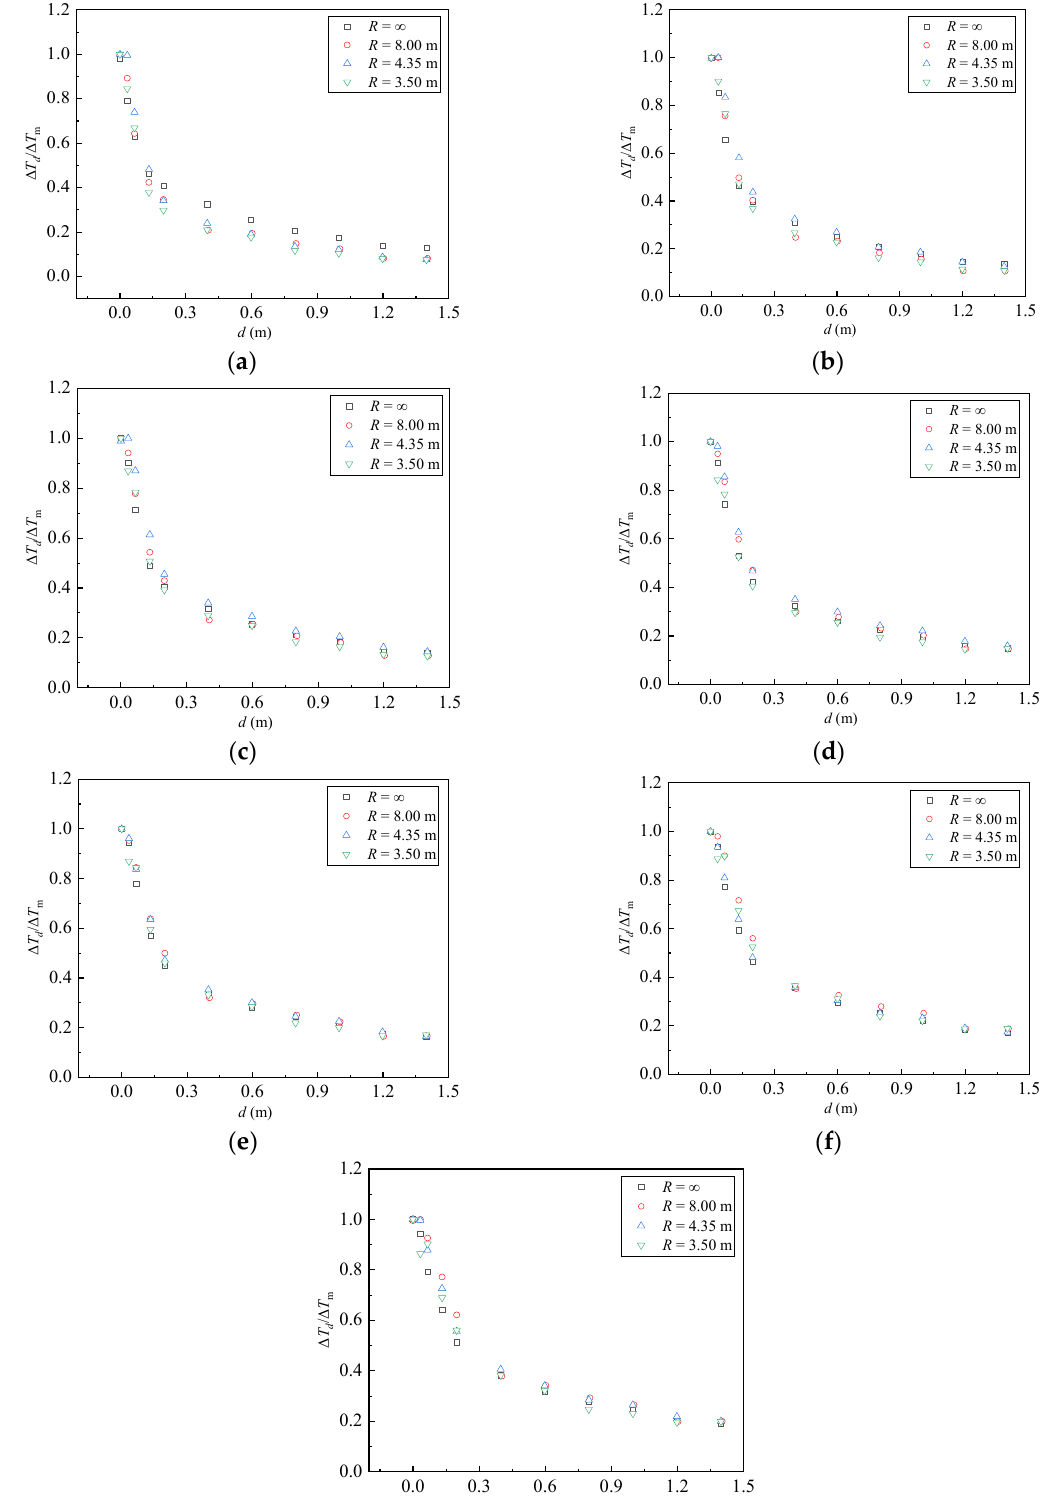
Figure 8. Longitudinal attenuation of temperature below the tunnel ceiling with different turning radiuses: ( a ) ∆ T m ) against the tunnel turning radius: ( a ) . Q = 2.03 kW; ( e ) ( d )